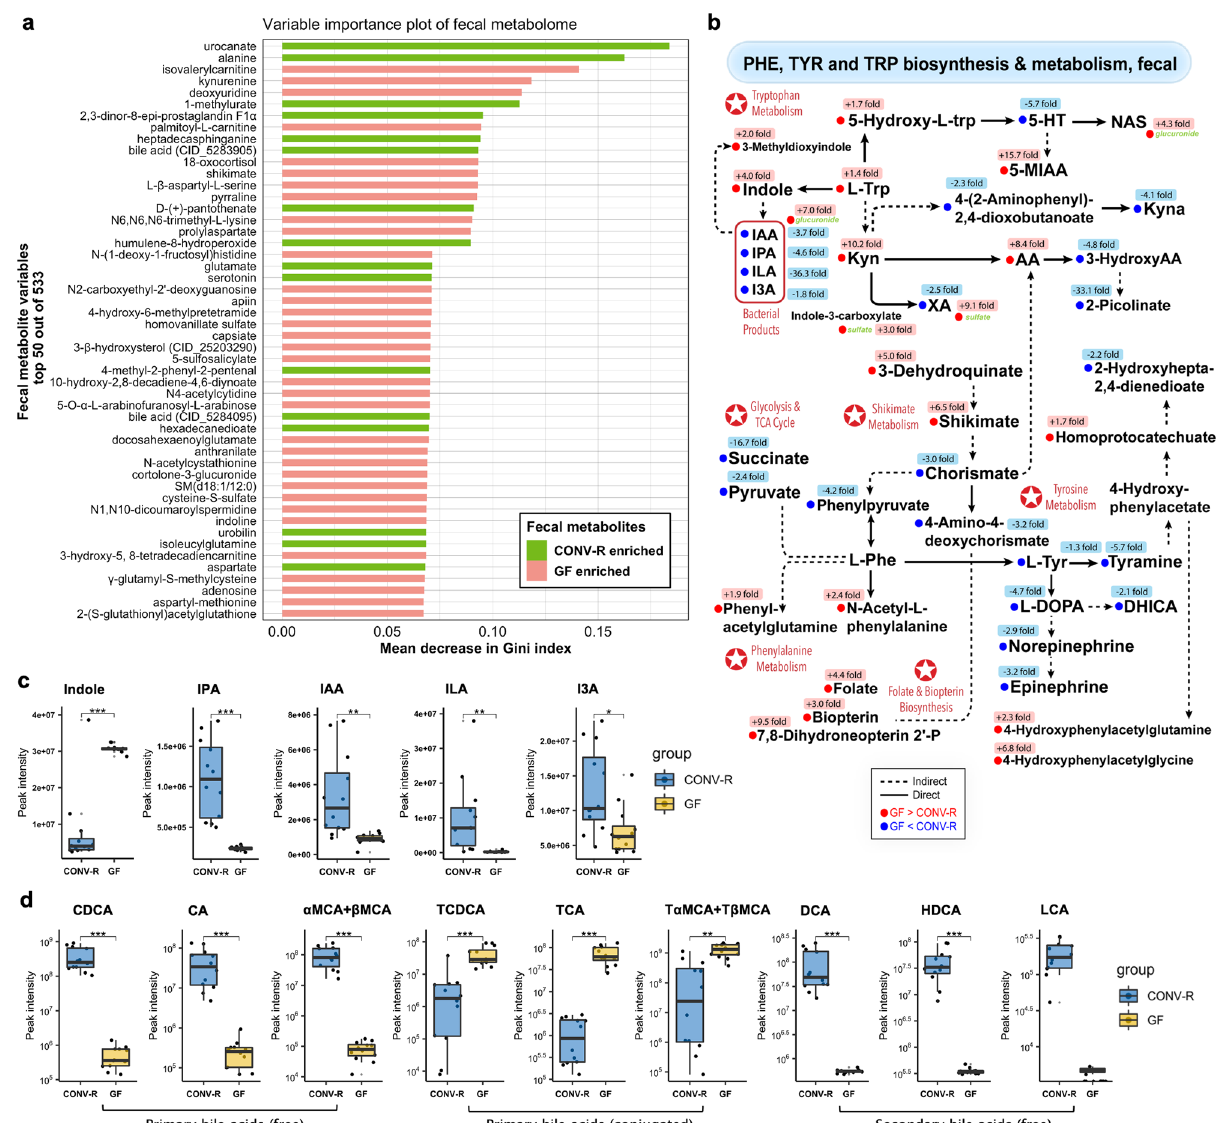
Fig. 3 Select high-impact gut metabolites and pathways as regulated by microbiota. a Variable importance plot of top 50 fecal metabolites ( y -axis) ranked by contribution to mean decrease accuracy of Gini coef fi cient ( x -axis) in the random forest model for discerning group difference. b Diagram summary of perturbed fecal pathways of phenylalanine, tyrosine, and tryptophan biosynthesis and metabolism, with signi fi cantly altered metabolites labeled in red (GF>CONV-R) or blue (GF<CONV-R) (two-sided Welch ’ s t -test, fold change ≥ 1.5, p <0.01). c, d Box and Whisker plots of fecal indoles ( c ) and bile acid pro fi les ( d ) as synthesized or mediated by microbiota, with the box ranging from the fi rst quartile to the third while the whiskers going from each quartile to the minimum or maximum (GF, N = 12; CONV-R, N = 12), * p <0.05, ** p <0.01, *** p <0.001, **** p <0.0001, two-sided Welch ’ s t -test; exact p values and adjusted p values (i.e., q values) are provided in Supplementary Data 2. SM sphingomyelin, Phe L-phenylalanine, Tyr L-tyrosine, Trp L-tryptophan, 5-HT 5-hydroxytryptamine, NAS